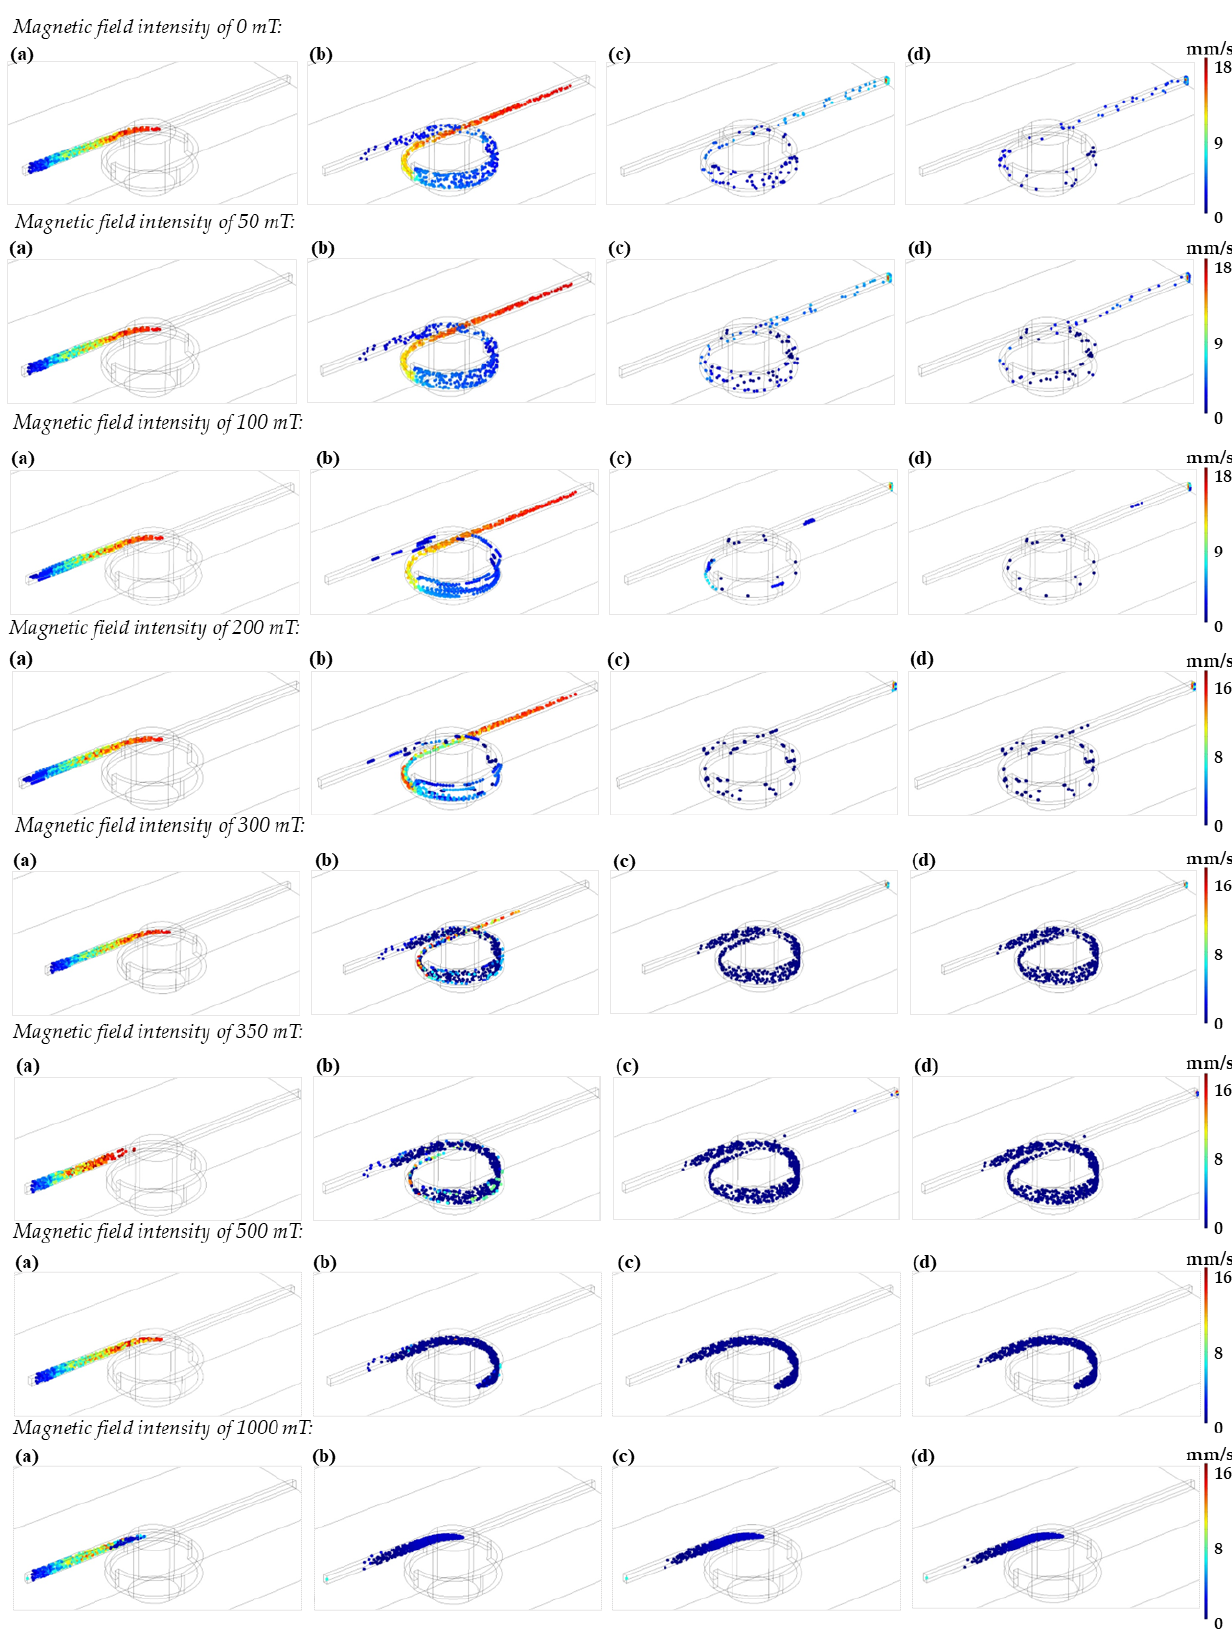
Figure 6. ( a ) Particle distribution in the one-loop microreactor after 1 s. ( b ) Particle distribution in the one-loop microreactor after 5 s. ( c ) Particle distribution in the one-loop microreactor after 15 s. ( d ) Particle distribution in the one-loop microreactor after 25 s.